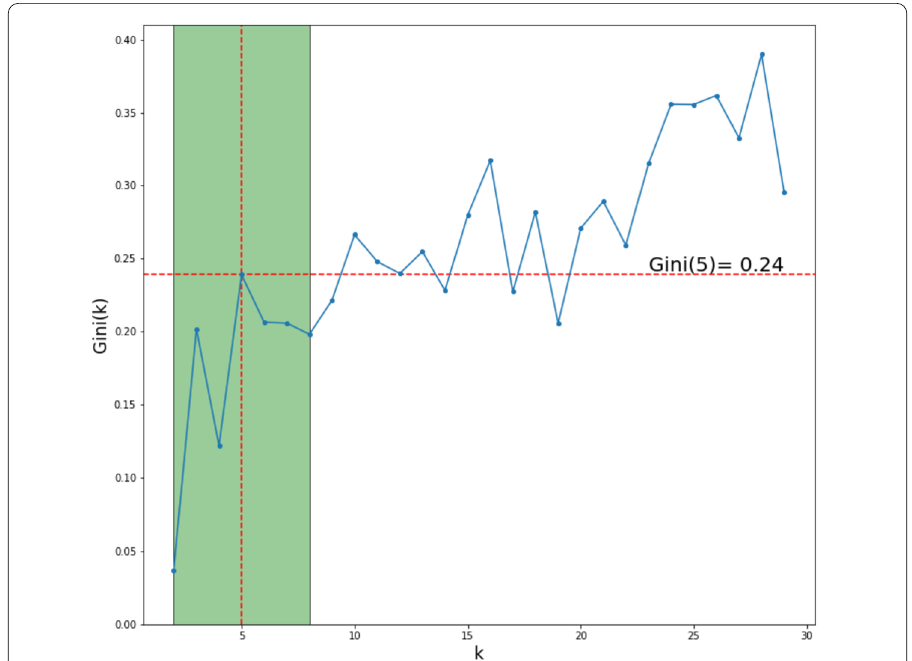
Figure 4 Gini coefficient for different values of K . K = 5 was chosen as it maximizes the coefficient. The green area refers to the values of K that we kept into consideration for the final choice